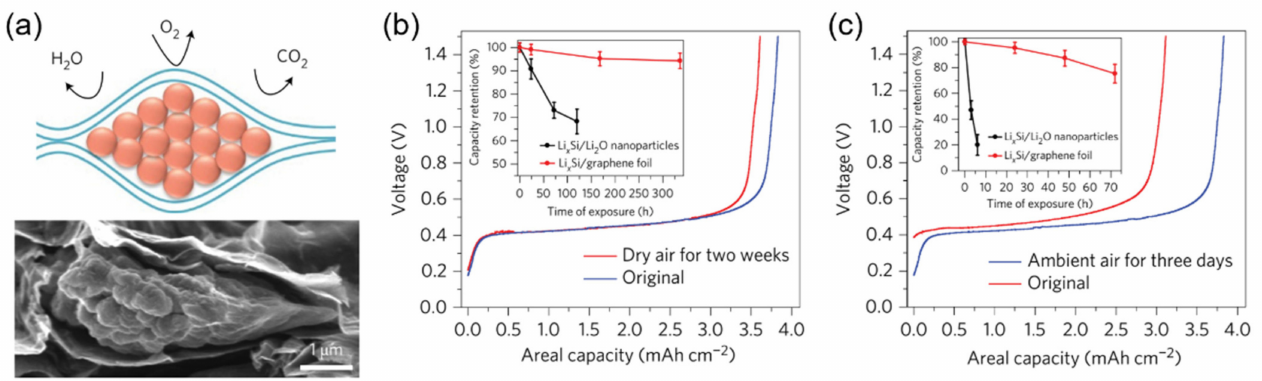
Figure 10. ( a ) Top: Schematic drawing of graphene sheets to avoid gas penetration. Bottom: Cross-sectional SEM image of Li x Si nanoparticles encapsulated by the graphene sheets. ( b ) The capacity retention of the Li x Si/graphene composite anode in the dry room for two weeks. ( c ) The capacity retention of the Li x Si/graphene composite anode in ambient air for three days. Reproduced with permission from ref. [98]. Copyright 2017, Nature Publishing